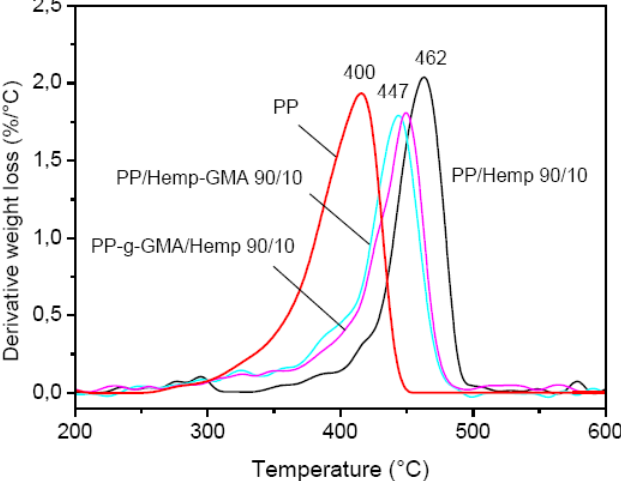
Figure 7 . DTG curves of PP/Hemp and PP/PP-g-MA/Hemp composites (in N